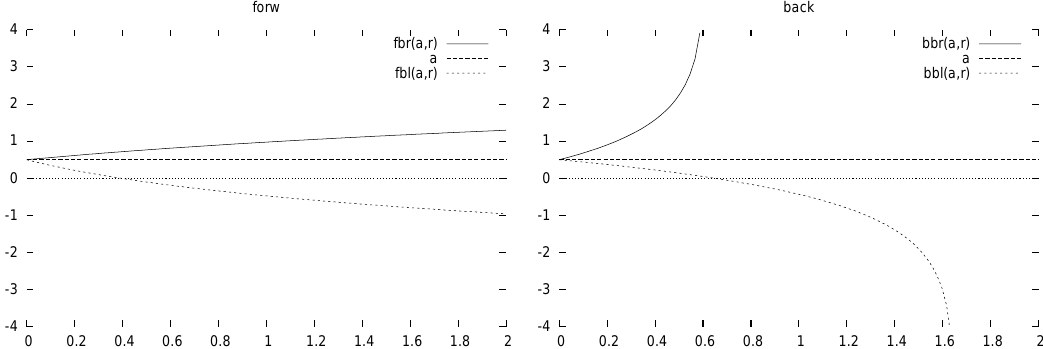
Fig. 2. f orward and b ackward b alls, l eft and r ight extrema ( M is vertical, a = 1/2 , r in